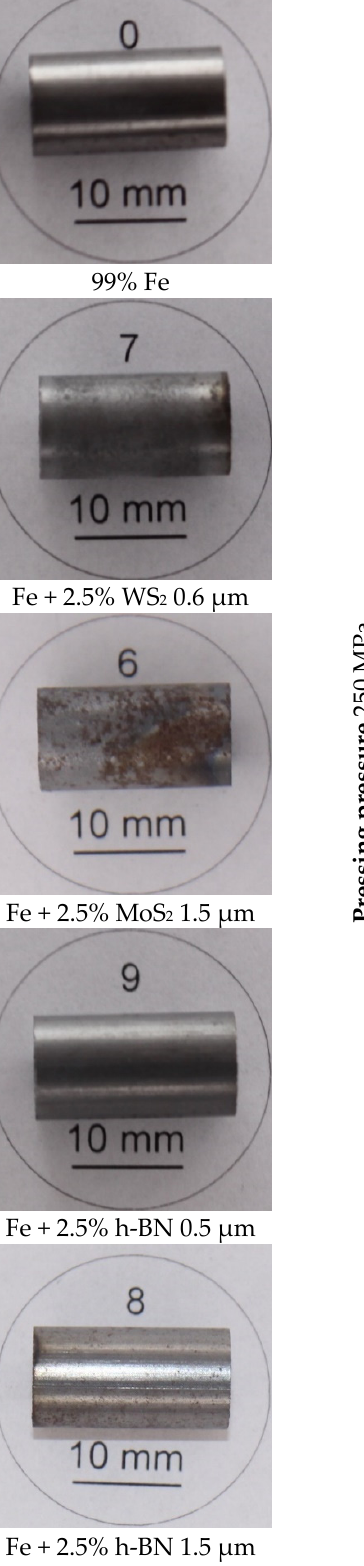
Figure 21. The appearance of the samples after keeping them in the room for one year.